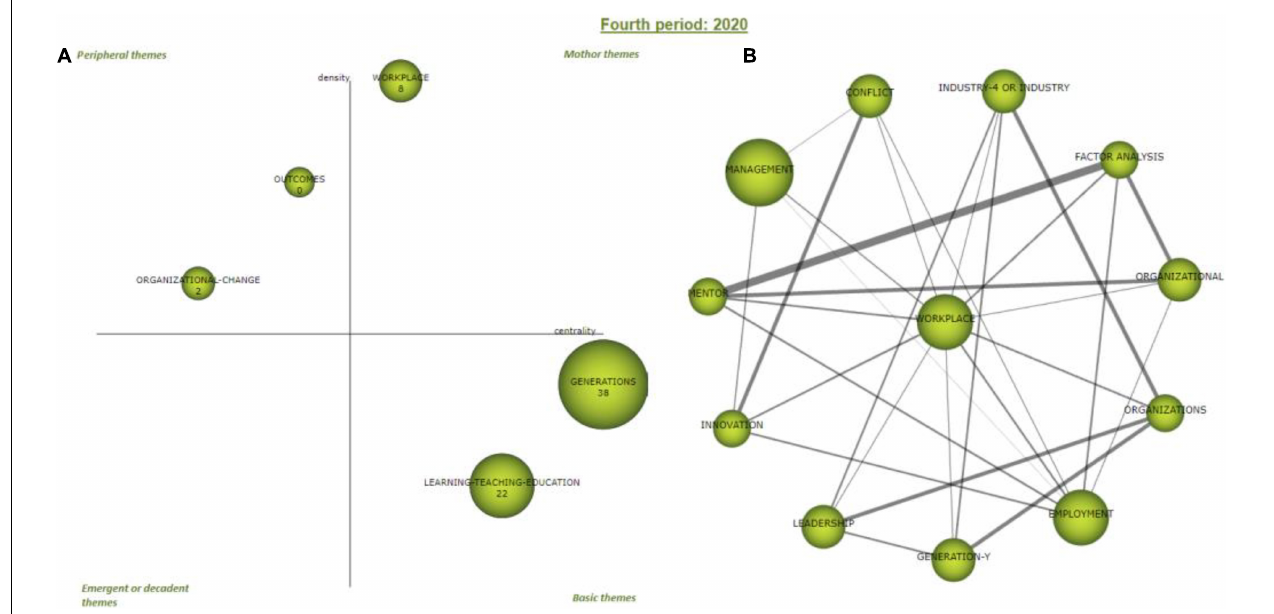
FIGURE 8 | Period 2020 strategic diagram (A) and motor cluster’s network (B) . Source: elaborated with SciMAT.